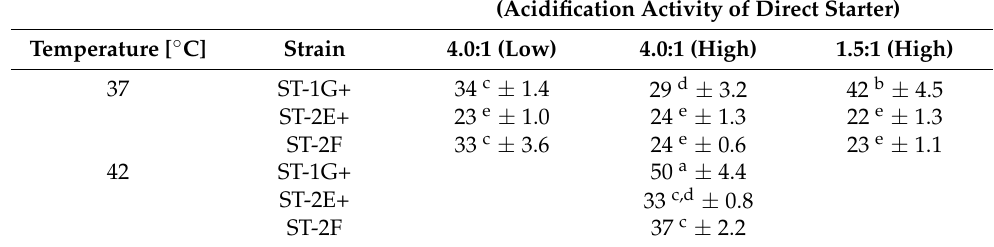
1 Arithmetic mean ± standard deviation. Means with different letters are significantly different ( p <